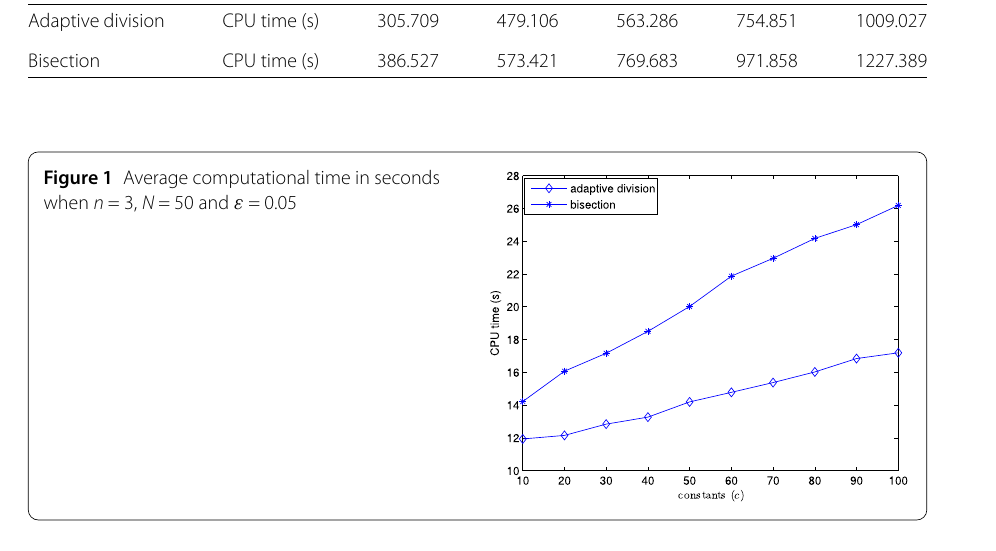
Figure 2 Average computational time in seconds when n = 3 and ε = 0.05